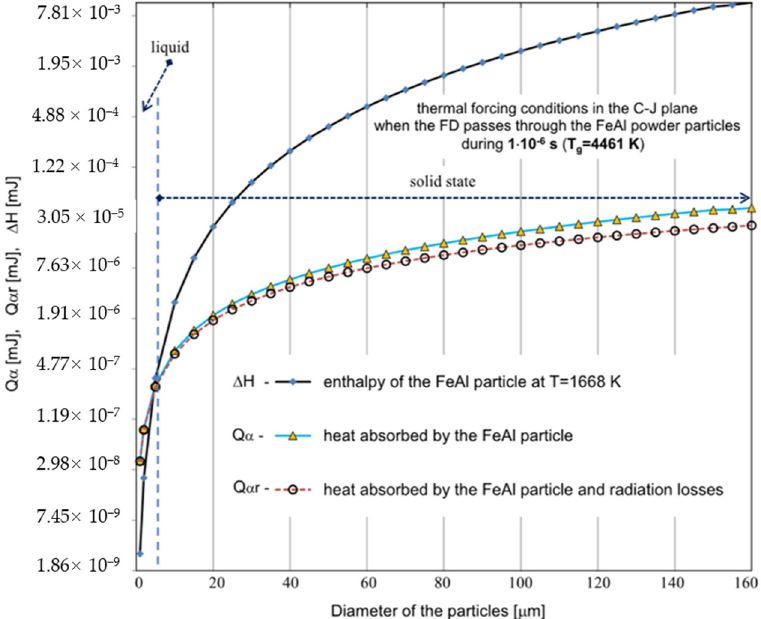
Figure 5. Comparison of the calculated values for the thermal energy Q α absorbed by the powder particles with the enthalpy of the FeAl alloy in the solid state at the melting temperature ∆ H, for different values of the particle diameter ranging from 1 µ m to 160 µ m. For the calculations, the parameters corresponding to the temperature of the gaseous medium of T = 4461 K during its interaction time of τ A = 1 × 10 − 6 s were adopted (the dashed line represents the results of the Q α r calculations considering radiation losses).